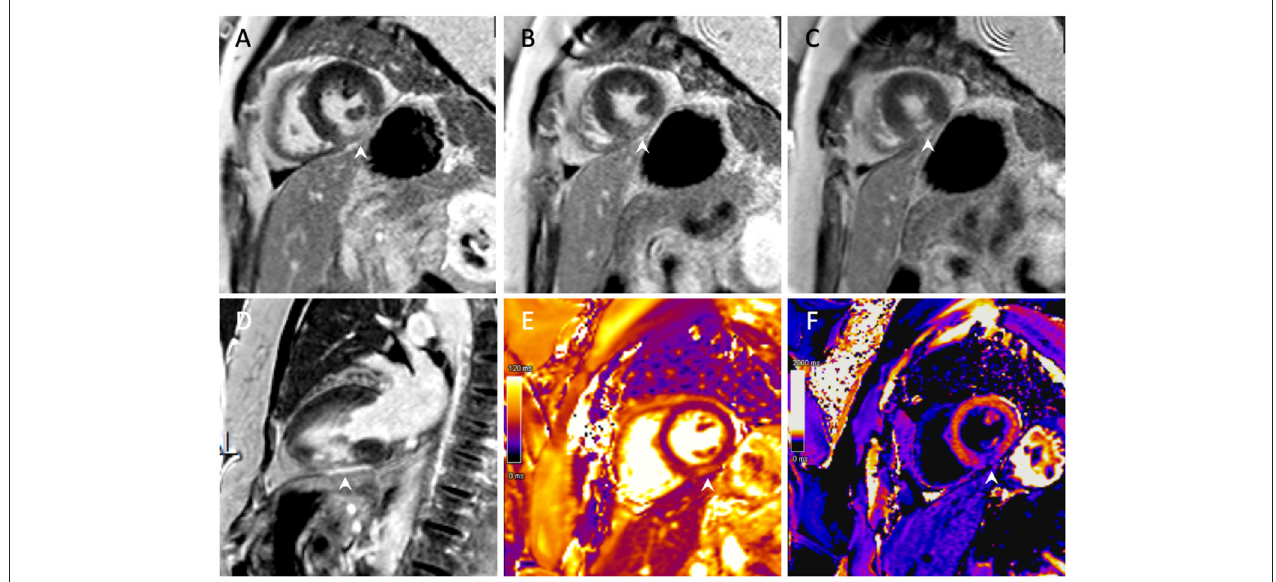
FIGURE 4 | Cardiac magnetic resonance imaging with gadolinium. (A–C) Short-axis view with transmural late gadolinium enhancement of the mid-inferior left ventricular wall with subendocardial extension toward the apex. (D) Two-chamber view demonstrating an inferior infarction of the mid segment with extension toward the apex. (E) T2 imaging with oedema of the mid-inferior segment. (F) Post-contrast T1 mapping of the